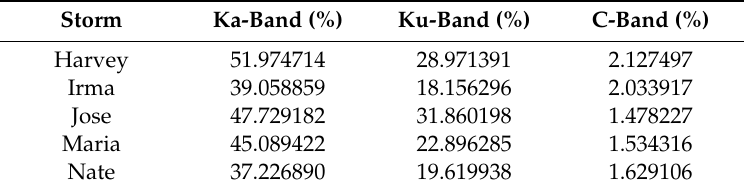
Table 4. Percentage of Rain Contamination (Serious and Side Lobe) using 8.25 km Footprint.